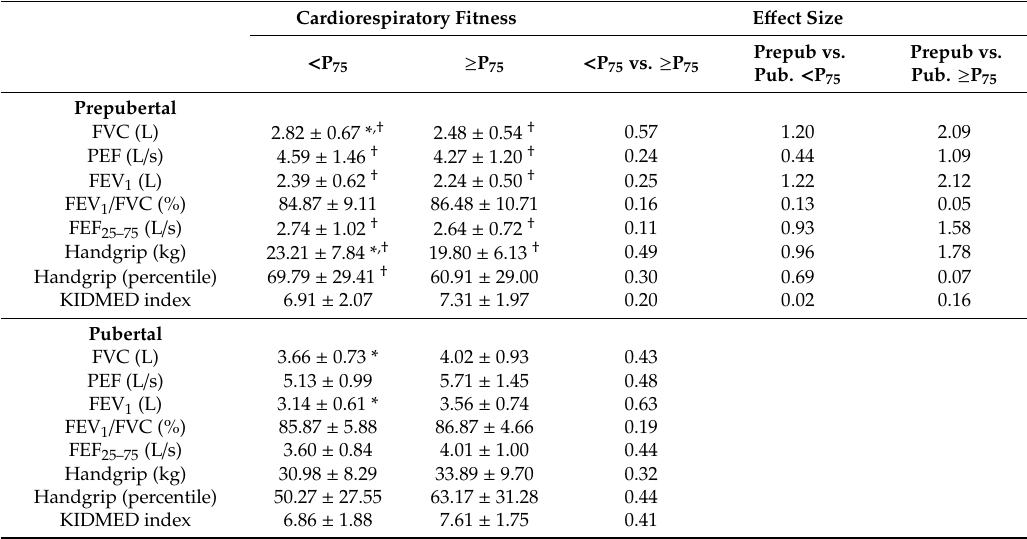
Comparisons of respiratory variables, handgrip strength, and adherence to the Mediterranean